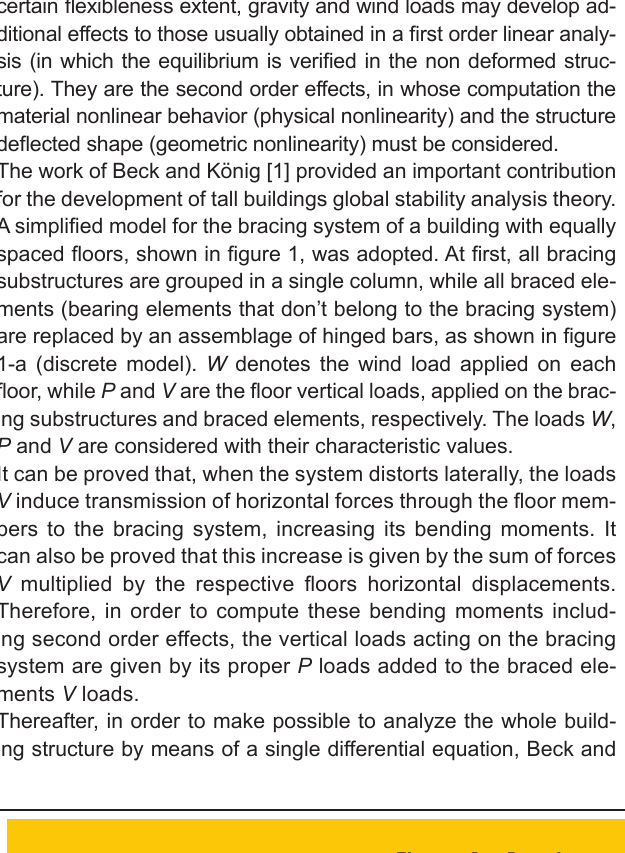
Figure 1 – Bracing system simplified